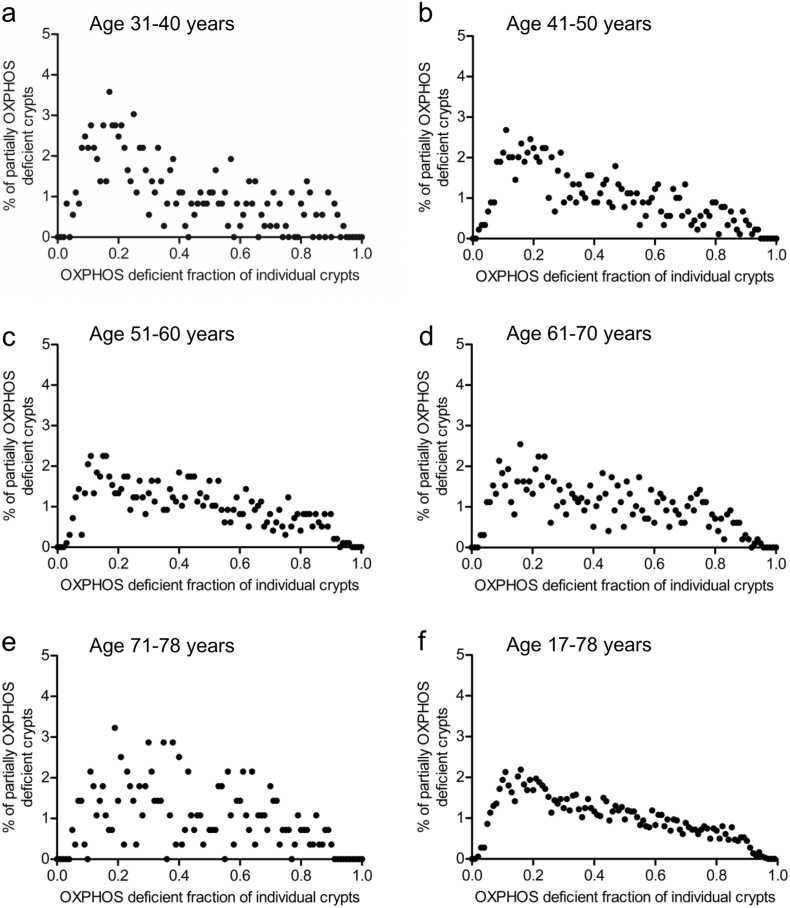
Frequency distribution of the fraction of OXPHOS deficiency in all partial crypts.Data are grouped by age (a–e) then plotted as the whole data set (f). The <30 age bracket had too few data points for age-group analysis, but was included in the total data analysis.